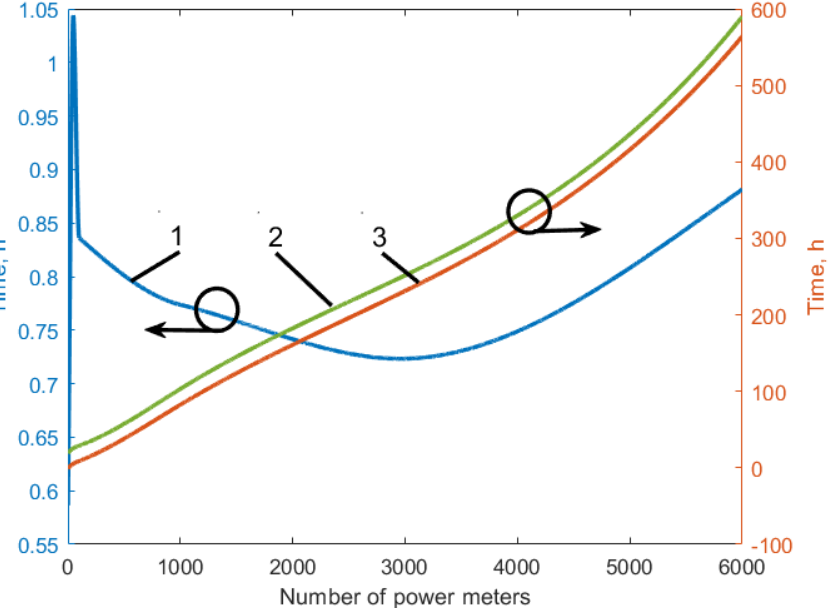
Figure 10. The produced artificial data traffic, when 50 GB data stream was produced and repeatedly broadcast during the trial, when 1—transmission time of one power meter, 2—transmission time of all power meters selected, 3—receiver time in system of all power meters